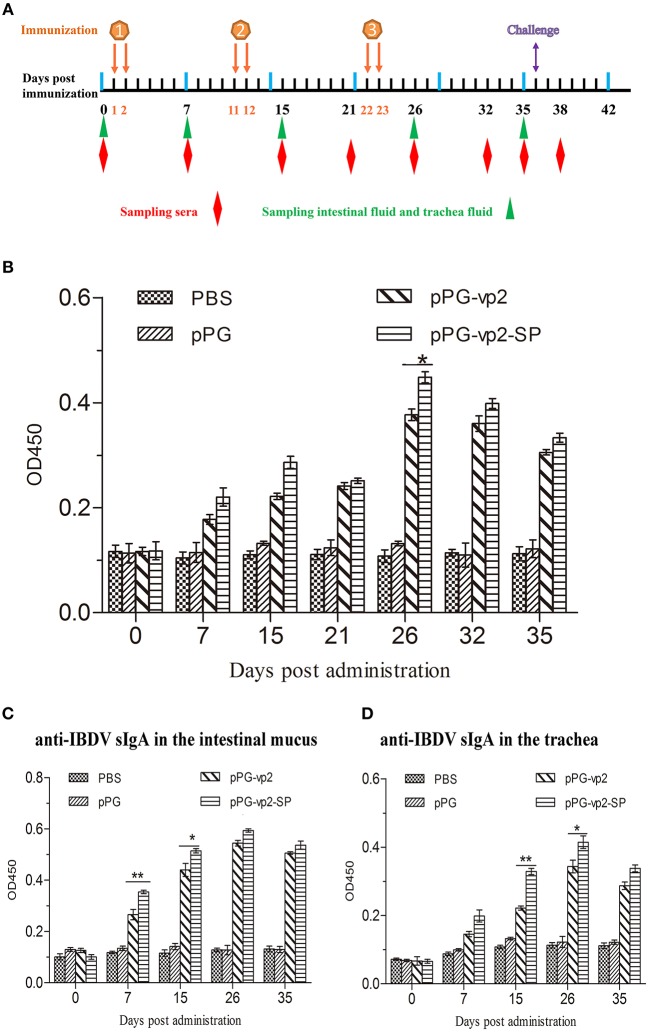
Detection of anti-IBDV-specific IgY and sIgA antibody levels. Scheme of oral immunization and sampling of sera, intestinal mucus, and trachea fluid (A). Primary immunizations were carried out on two consecutive days (days 1 and 2). Booster immunizations were carried out on days 11, 12, 22, and 23. Anti-IBDV-specific IgY antibody levels in the sera (B). Groups (n = 4) of SPF chickens were orally immunized with recombinant strains and PBS. Anti-IBDV-specific sIgA levels in the intestinal mucus (C) and trachea fluid (D) post-immunization with recombinant strains. Bars represent the mean ± standard error value of each group (*p < 0.05, **p < 0.01).